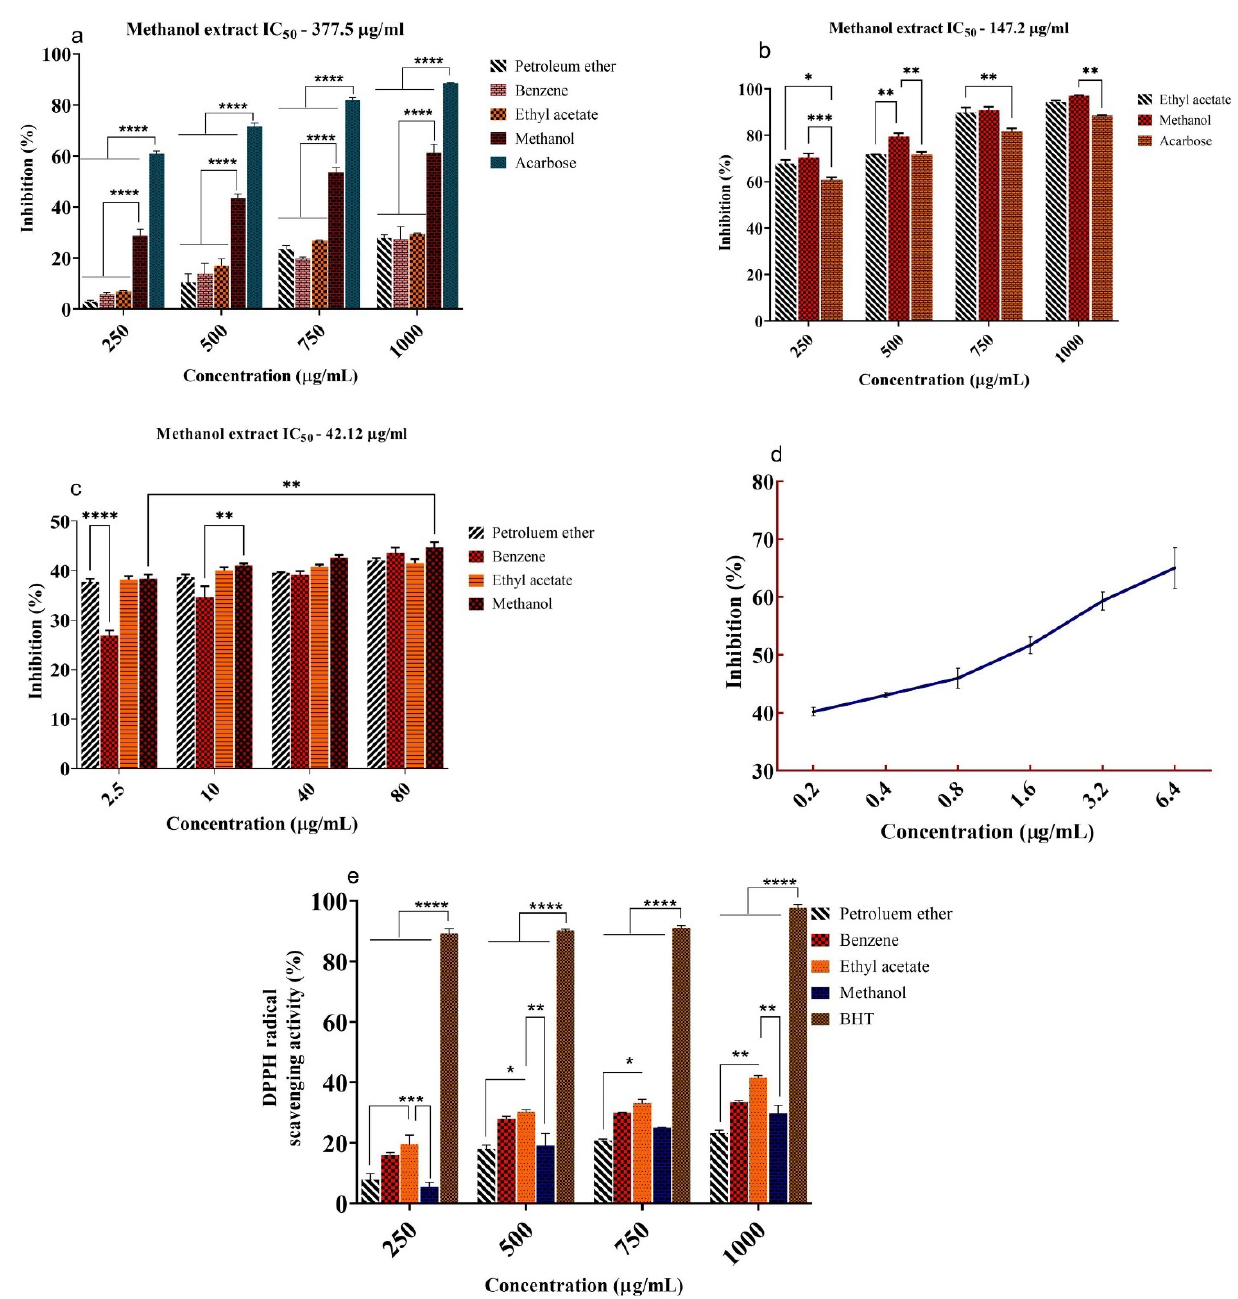
Figure 1. In vitro antidiabetic ( α -amylase, α -glucosidase, and DPP-IV) and antioxidant activity of U. reticulata . ( a ) α -amylase, ( b ) α -glucosidase, ( c ) DPP-IV inhibitory, ( d ) Diprotin A and ( e ) antioxidant activity of seaweed extracts. Absorbance was measured at 540, 405, and 517 nm, respectively. All the extracts were compared with standards acarbose, Diprotin A, and BHT, where n = 3 for each sample with S.E.M. The mean values were analyzed using two-way ANOVA (Tukey’s multiple comparisons test). **** p < 0.0001, *** p < 0.001, ** p < 0.01, * p < 0.05 considered as significant.